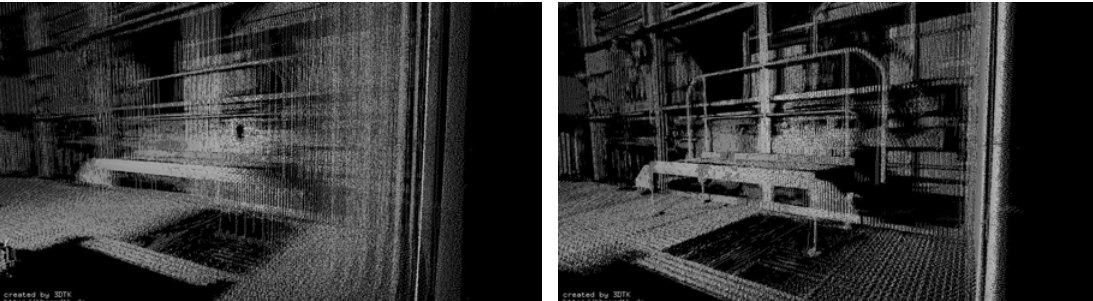
Figure 4: Left: Before applying our semi-rigid SLAM method. Right: Correction by our semi-rigid